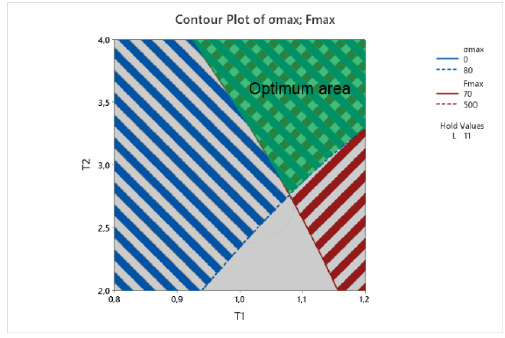
Figure 25. Contour plot of σ max ; F max and T 1; T 2